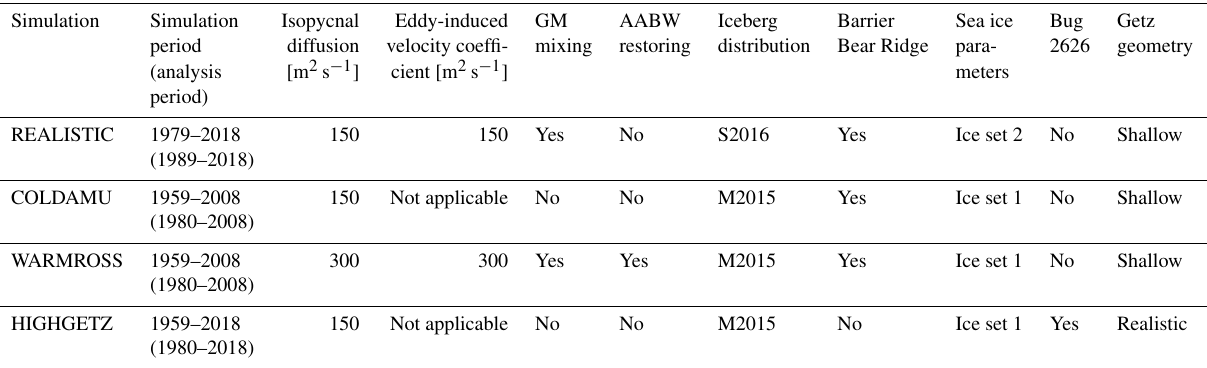
Table 1. Description of the differences between the four simulations used. The AABW (Antarctic bottom water) restoring is described in Dufour et al. (2012). GM mixing is a parameterisation of adiabatic eddy mixing (Gent and McWilliams, 1990) used where local resolution is coarser than half the local Rossby radius. S2016 and M2015 are the iceberg size distribution provided by Stern et al. (2016) and Marsh et al. (2015), respectively. The land barrier at Bear Ridge mimics the sea-ice blocking induced by grounded icebergs in that region. “Ice set 1” and “Ice set 2” make use of different sea-ice parameters. In Ice set 2 (compared to Ice set 1), the adaptive EVP rheology is turned off, the ice–ocean drag coefficient is set to 0.005 instead of 0.012, the snow conductivity is changed from 0.31 to 0.35Wm − 1 K − 1 , and the frazil ice formation scheme is turned off. “Bug 2626” stands for a bug on the distribution of solar and non-solar radiation originally present in NEMO-v4.0.4 and corrected since